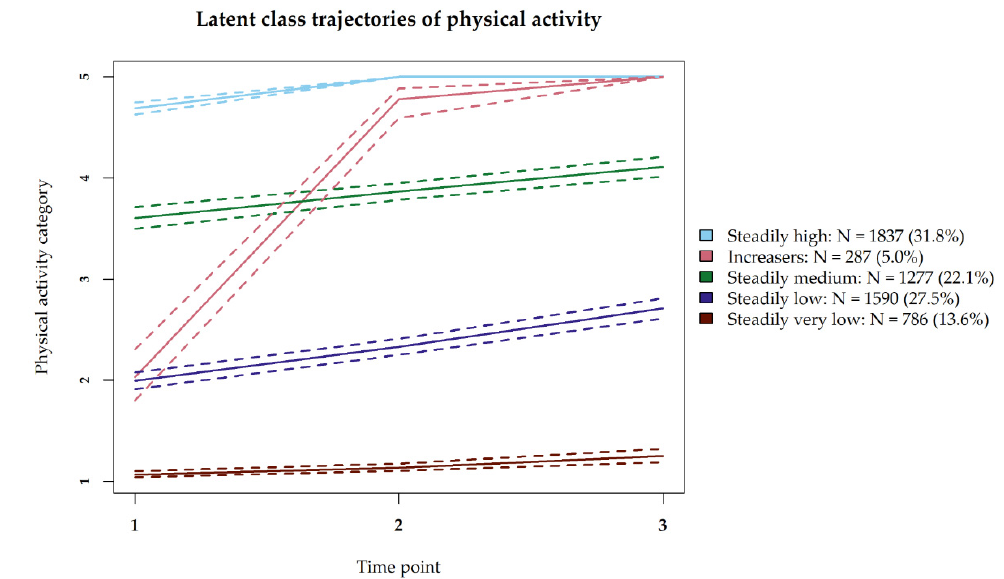
Figure 1. Trajectories of physical activity during COVID-19 pandemic. Question asked at each time point: “During the past 14 days, how many minutes did you exercise (moderately) intensively in total (walking, cycling, running)?”. Physical activity categories refer to the different answer options: 1 ‘Less than 50 min’, 2 ‘50–100 min’, 3 ‘100–150 min’, 4 ‘150–180 min’, 5 ‘More than 180 min’.